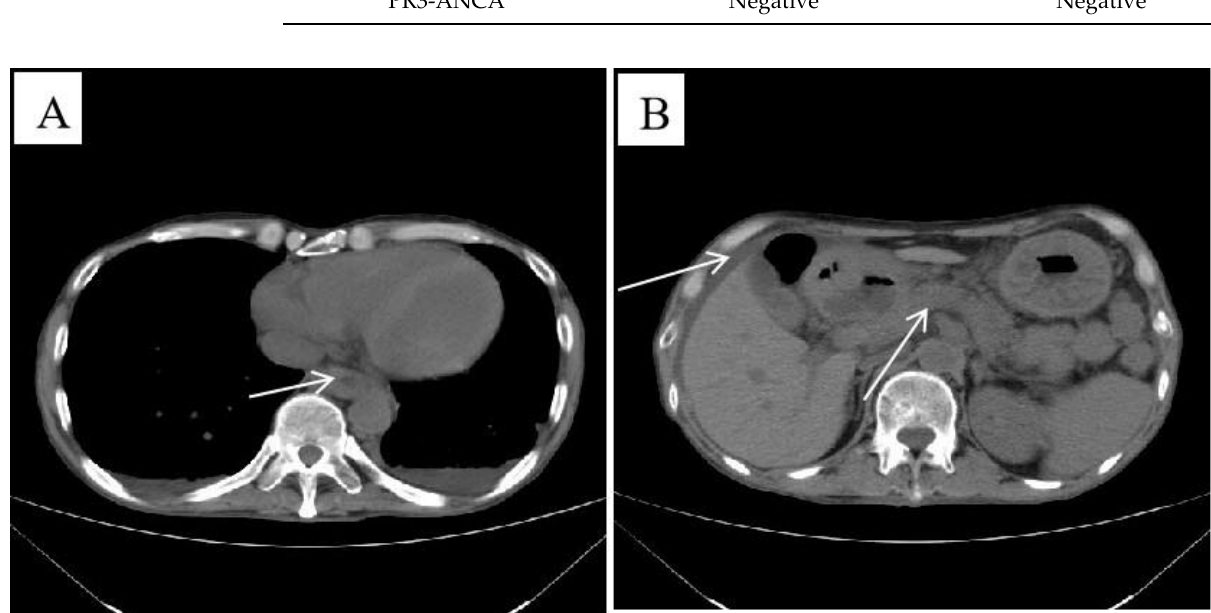
Figure 1. Chest and abdominal contrast-enhanced computed tomography (equipment type: Philips Brilliance CT 64 slice, Amsterdam, the Netherlands). ( A ) Image of the lower oesophageal wall, showing slight thickening (white arrow). ( B ) The pancreas appeared normal, with a small amount of ascites (white arrow).